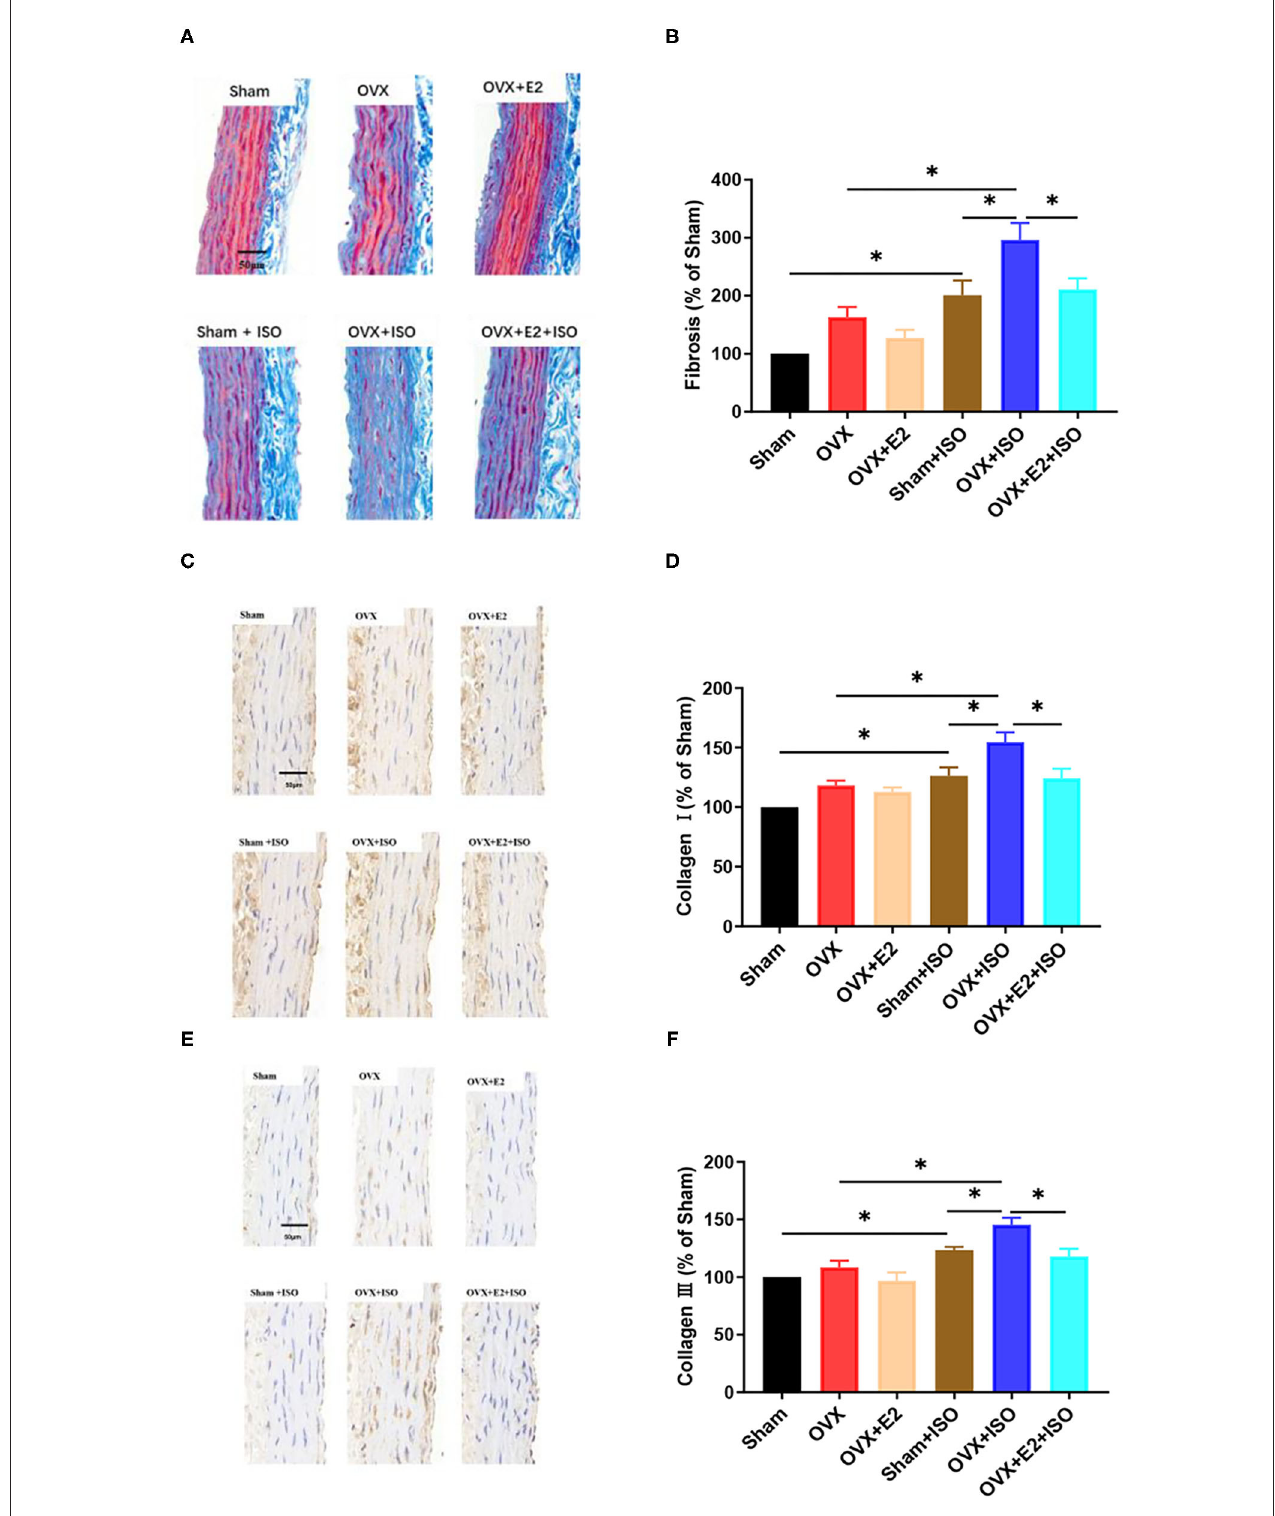
FIGURE 6 | Estrogen decreases interstitial collagen deposition in aortic vascular walls during catecholamine stress. (A, B) Representative trichrome staining of collagen depositions in aortic tissues and their quantifications. (C–F) Representative IHC staining of type I and III collagens in aortic tissues and their quantifications. Data are expressed as mean ± SEM. n = 6. * P < 0.05. Scale bar = 50 µ m.